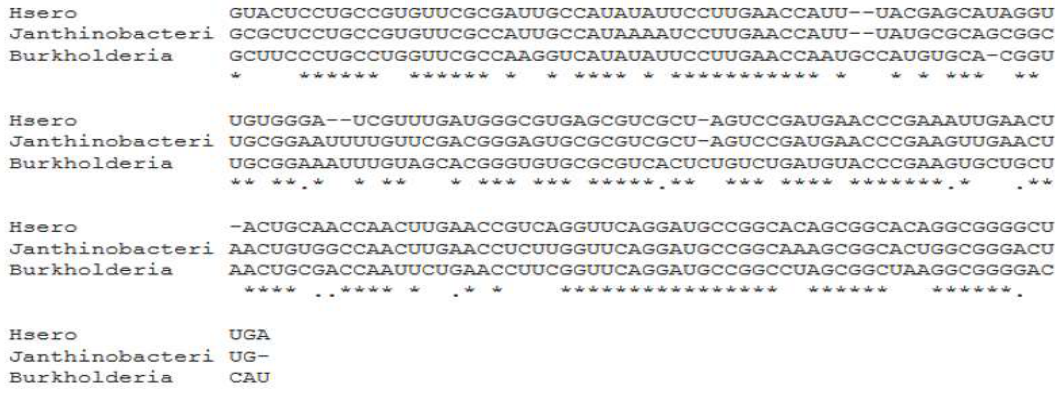
Figure 7. Visualization of the secondary structure of ncRNA 6S. ( a ) H. seropedicae SmR1; ( b ) Janthinobacterium sp.; ( c ) Burkholderia CCGE1003. A predictive analysis of the secondary structures of identified ncRNAs was conducted by means of RNAFold.